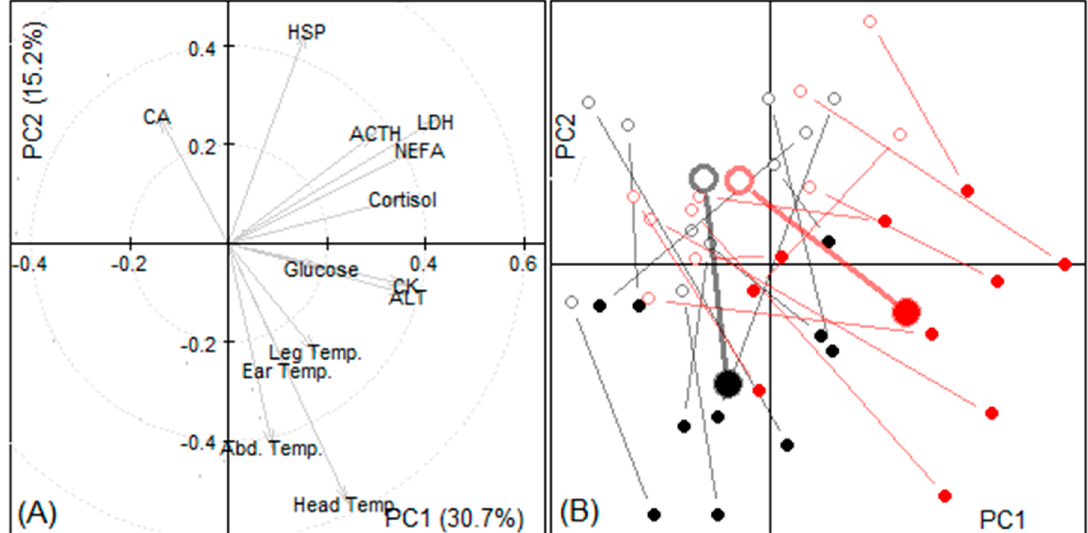
Figure 3. Results of principal component analysis of experiment 2 data. ( A ) The weights (eigenvectors) of variables in the first two principal components (PC). ( B ) Location of samples according to their first two PC scores sorted by treatment group (red: duration of transport 2 h, black: duration of transport 1 h) and time (departure: empty circles, arrival: filled circles); samples from the same animal are joined with a line, larger circles indicate groups’ means.